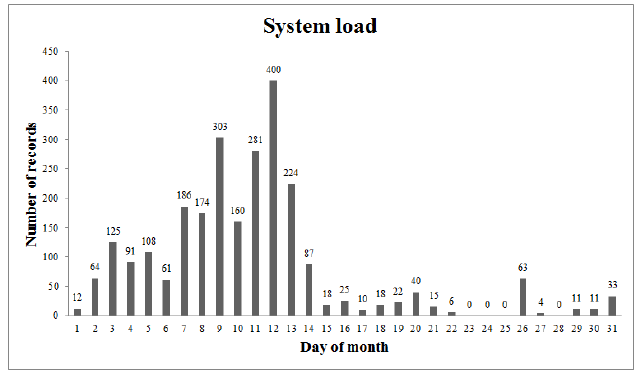
Fig. 6. ITS system